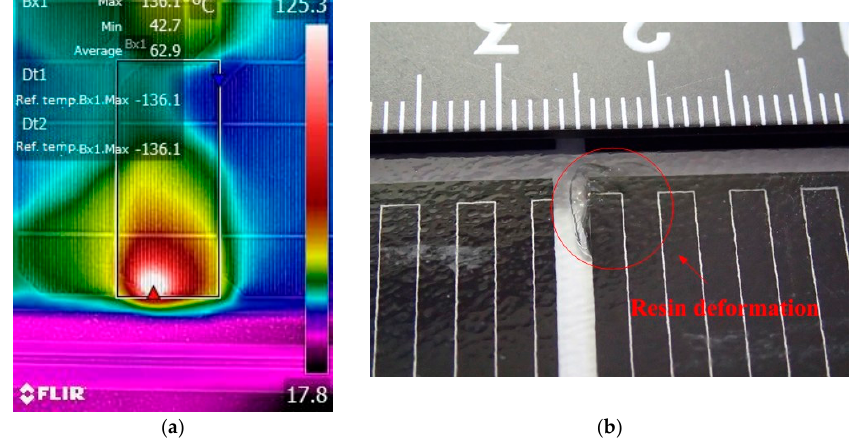
Figure 18. Example of resin deformation of defect cell: ( a ) HSI of this cell is 0% and the temperature reached 136 °C; ( b ) Resin deformation occurred at the edge of the defective cell.